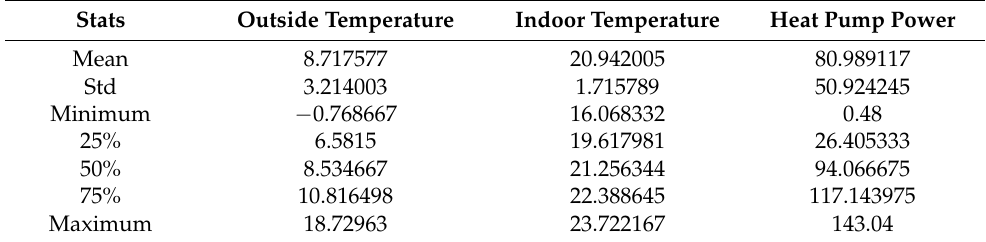
Table 1. Statistics of the